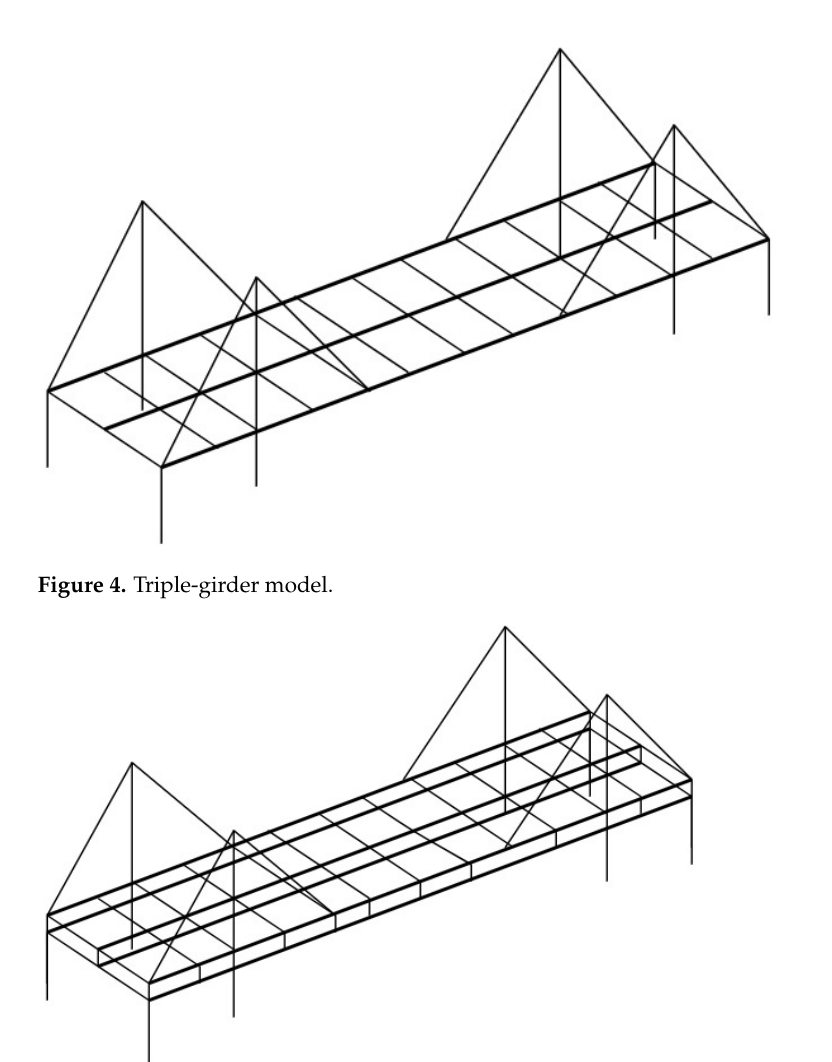
Figure 5. Multi-scale model with deck plate